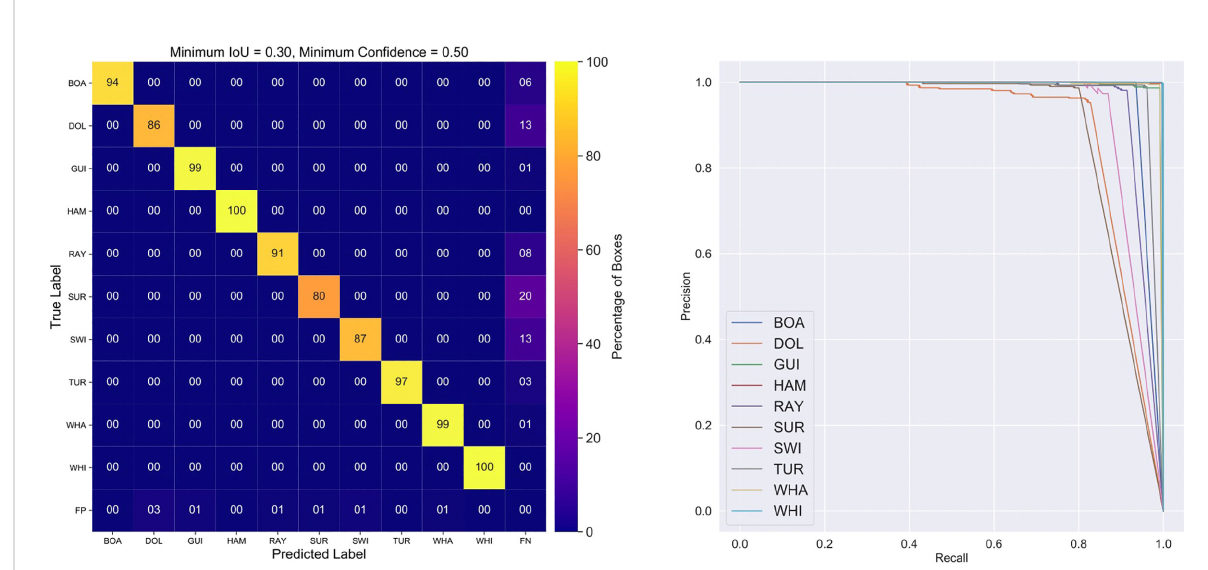
FIGURE 10 Confusion matrix (left) and precision-recall plot (right) for the fi nal MobileNet V1 backbone model applied to the internal testing dataset. The MobileNet V1 architecture performs similarly to RetinaNet 50, despite being more lightweight. Comparing this confusion matrix to Figure 8, we see that the MobileNet V1 model exhibits a few more false negatives (real objects not detected) in the rightmost column. However, taken as a whole, the network performs well on identifying dangerous shark species, with a mAP =